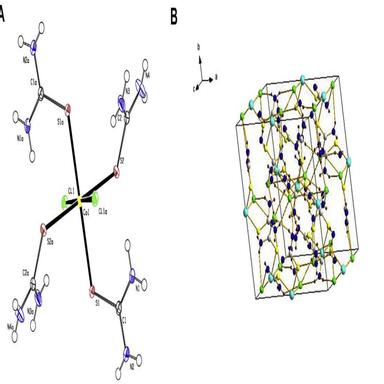
Asymmetric unit and the perspective view of tetrakis(thiourea)cobalt chloride single crystal.